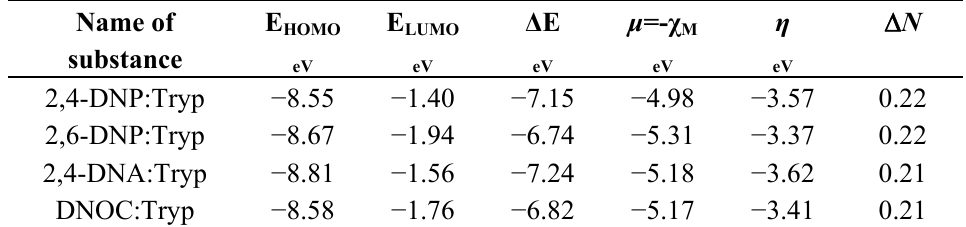
Table 7. Theoretical energy data calculated using the HyperChem program PM3 method.